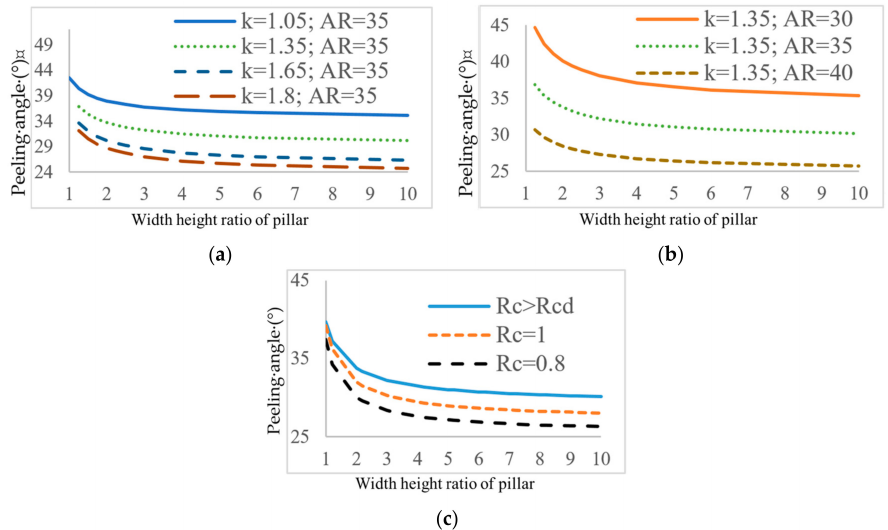
Figure 3. The relationship between the peeling angle and the width–height ratio of the pillar: k for bulk factor; AR for angle of repose; ◦ ; Rc and Rcd for room width–height ratio and critical room width–height ratio. For ( a , b ), the room width is larger than the critical room width; and for ( c ), the room width is smaller than the critical room width, k = 1.35; AR = 35 ◦